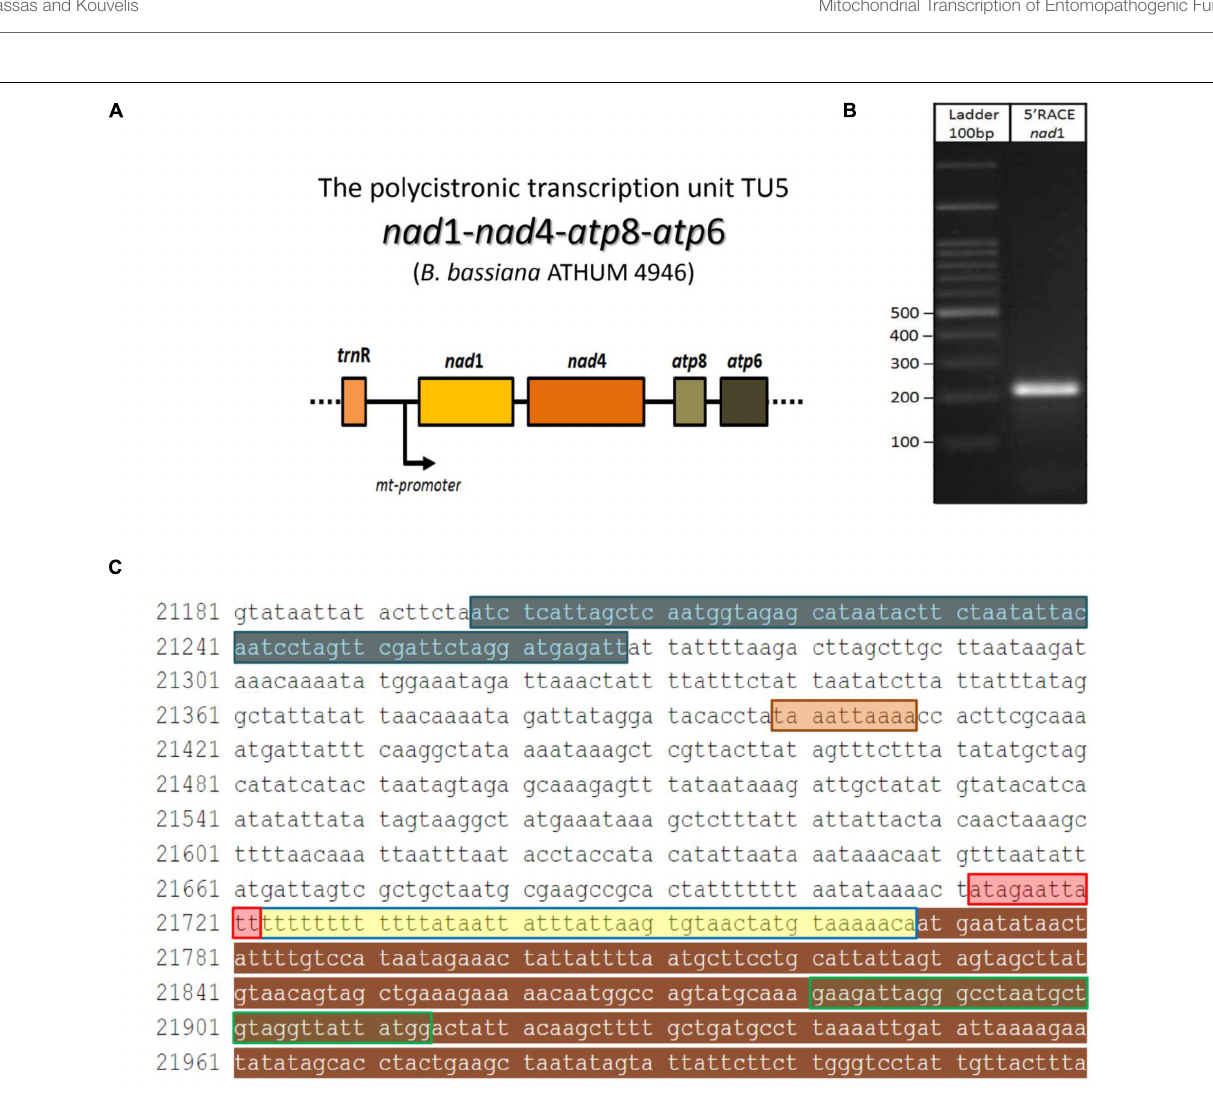
FIGURE 4 | The 5 (cid:48) UTR region of the polycistronic transcript nad 1- nad 4- atp 8- atp 6 (unit V) in the mt genome of B. bassiana ATHUM 4946. (A) Schematic representation of the polycistronic transcript. The arrow indicated the position of the mt promoter. (B) The amplicon obtained after the RACE-PCR experiment. (C) The trn R2— nad 1 sequence as retrieved from EU100742.1 whole mt genome of B. bassiana . Sequence regions of the amplicon: the trn R gene, the 5 (cid:48) end partial nad 1 gene, the promoter sequence and the 5 (cid:48) UTR (as read by the 5 (cid:48) end RACE-PCR) are highlighted in blue, brown, red, and yellow, respectively. The primer nad1R which was used for the 2nd PCR of the RACE, is shown in green line box. The termination sequence of the previous transcript (Unit IV) is highlighted in